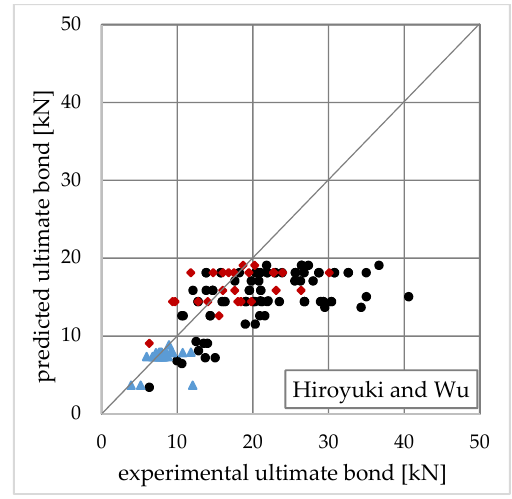
Figure 3. Test vs. predicted bond force using the Hiroyuki and Wu model [15].